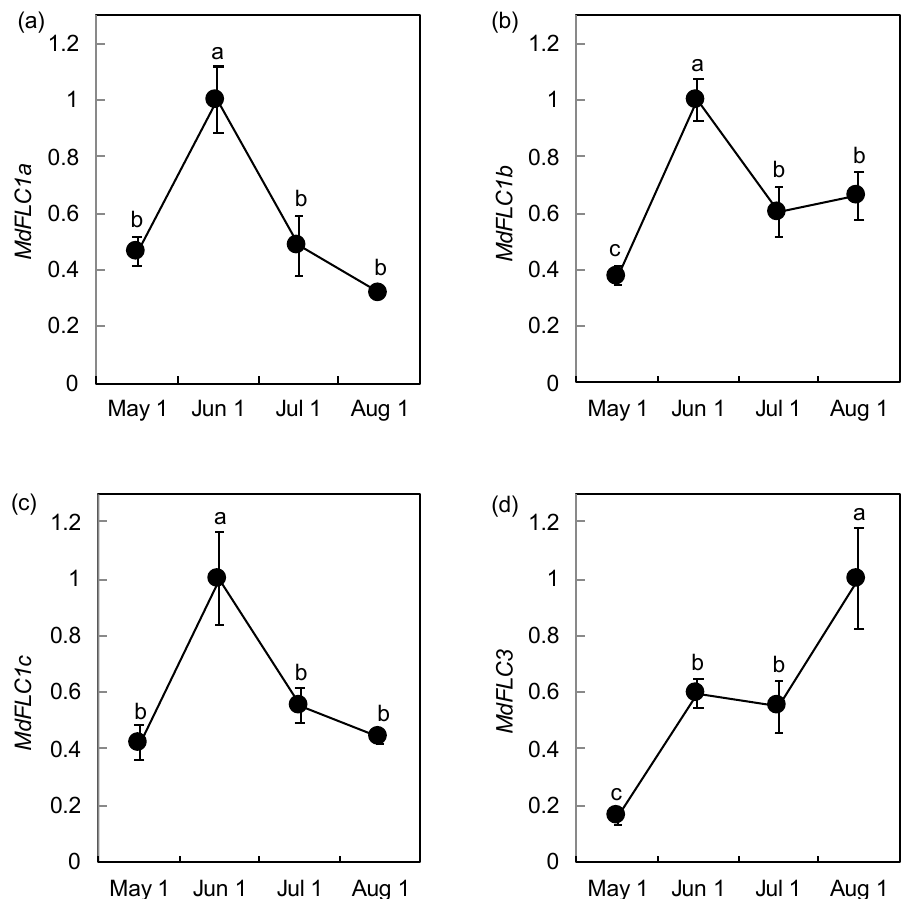
Figure 3. Seasonal changes in the expression levels of MdFLC1a ( a ), MdFLC1b ( b ), MdFLC1c ( c ), and MdFLC3 ( d ) in the leaves of adult trees. Total RNA was prepared for the expression analysis of MdFLC1 and MdFLC3 on May 1, June 1, July 1, and August 1, 2016. Relative expression was determined using triplicate measurements taken from three independent biological replicates. The relative expression levels were normalized against MdACTIN with standard errors, and the maximum level of the transcripts was set at 1.0. The values with di ff erent letters for each gene significantly di ff ered between days at p < 0.05, according to a Tukey test.